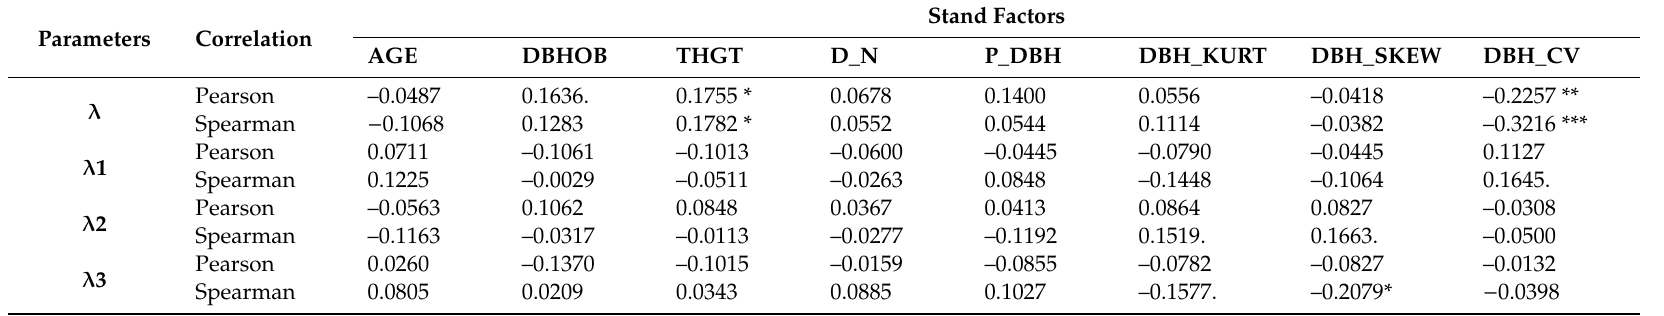
Table 8. Pearson correlation coe ffi cient and Spearman correlation coe ffi cient between parameters and stand factors.